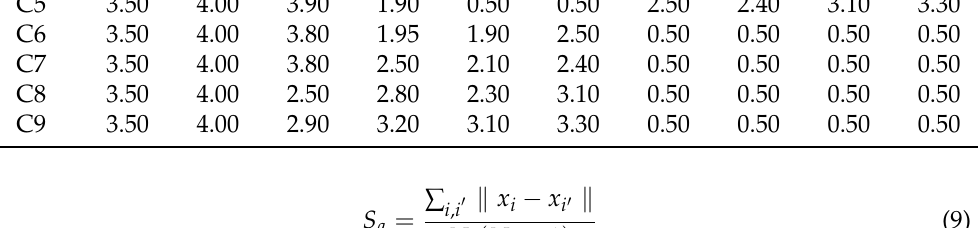
Here, x i is the number of intraclass feature attributes, x i − x i (cid:48) is distance, and N k is total number of